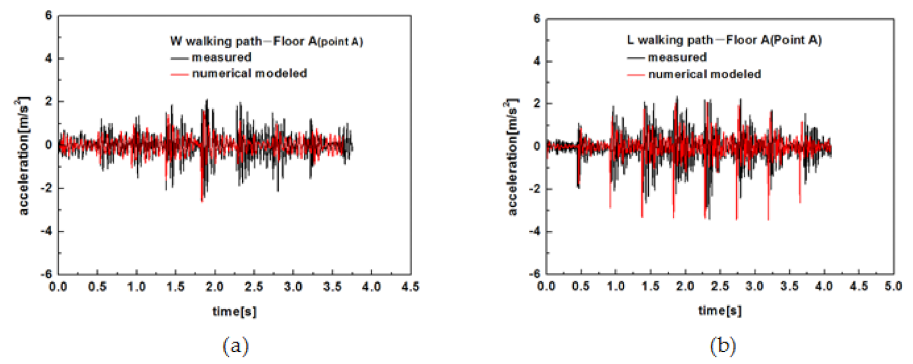
Figure 19. Acceleration responses at points A for Floor A: ( a ) W path and ( b ) L